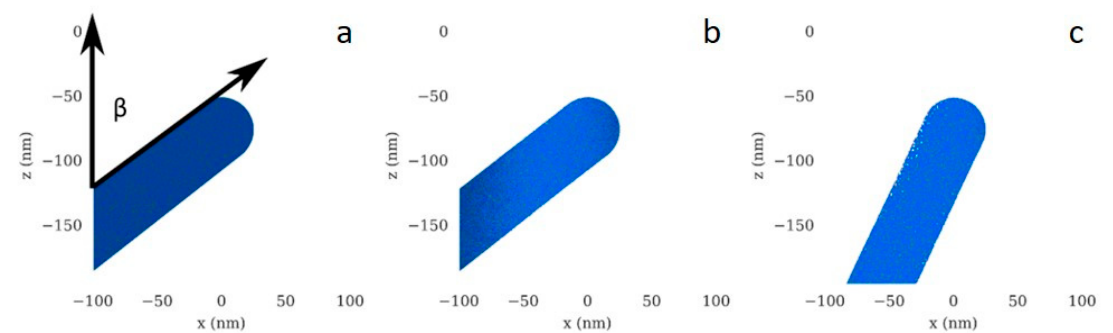
Figure 4. EnvizION Monte Carlo simulation results. ( a ) Schematic of the initial geometry for sputtering simulations. ( b ) Pillar corresponding to the 4 ms dwell time scan (~5.6 million ions), and ( c ) pillar corresponding to the 12 ms dwell time scan (~16.8 million ions). Table 1. Sputter yields of each species for the sputtering simulations of the pillars in Figure 2. Dwell Time